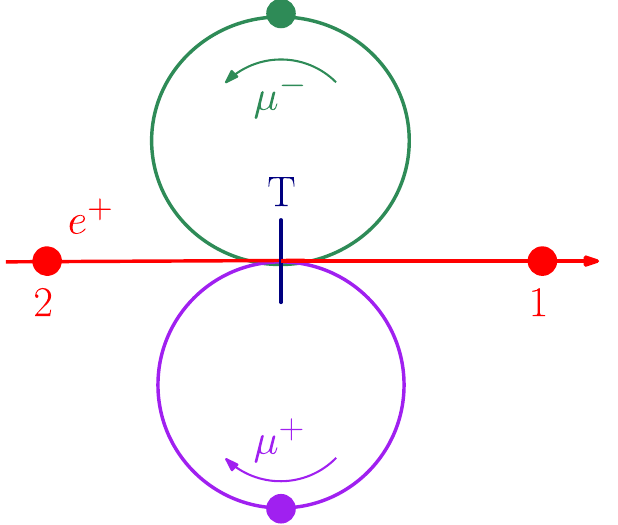
beams.FIG. 1. Schematic representation of the LEMMA accumulation scheme. Two muon bunches, one positive and one negative, have been produced by the interaction of the first positron bunch (1) with the target ( T ). Muons are recirculated in synchronicity with the arrival of a second positron bunch (2) to increase the muon bunch population with minimal emittance